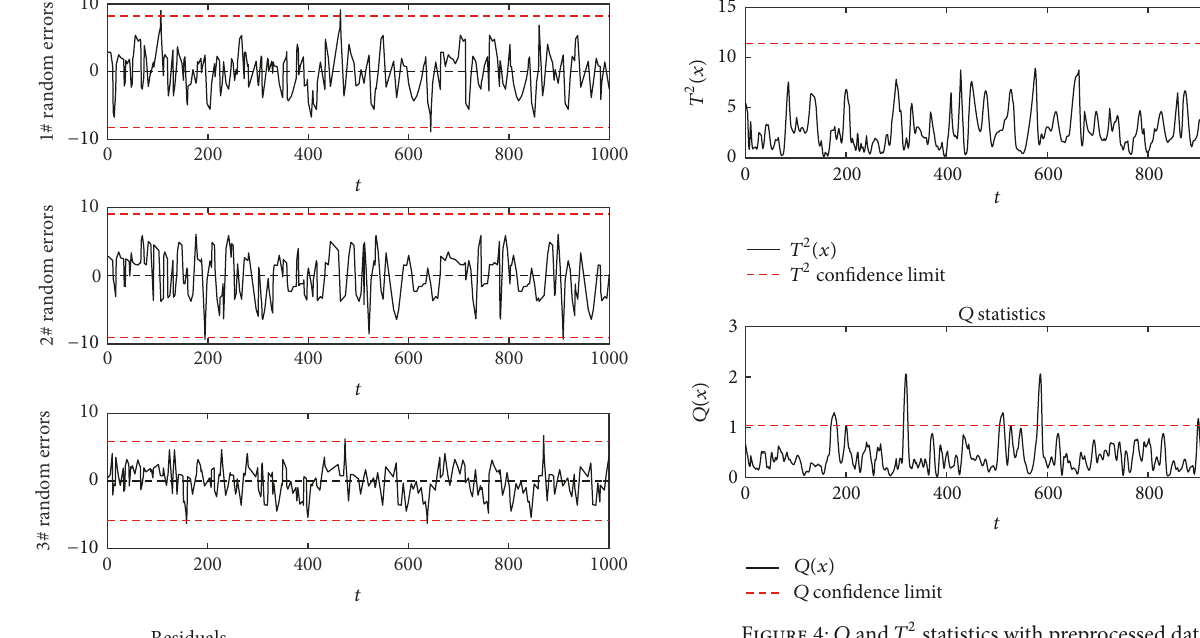
of sensor 𝑥 . If 𝑥 𝑖 satisfies (5), 𝑥 𝑖 will be treated as a singular point and eliminated from the original data directly.